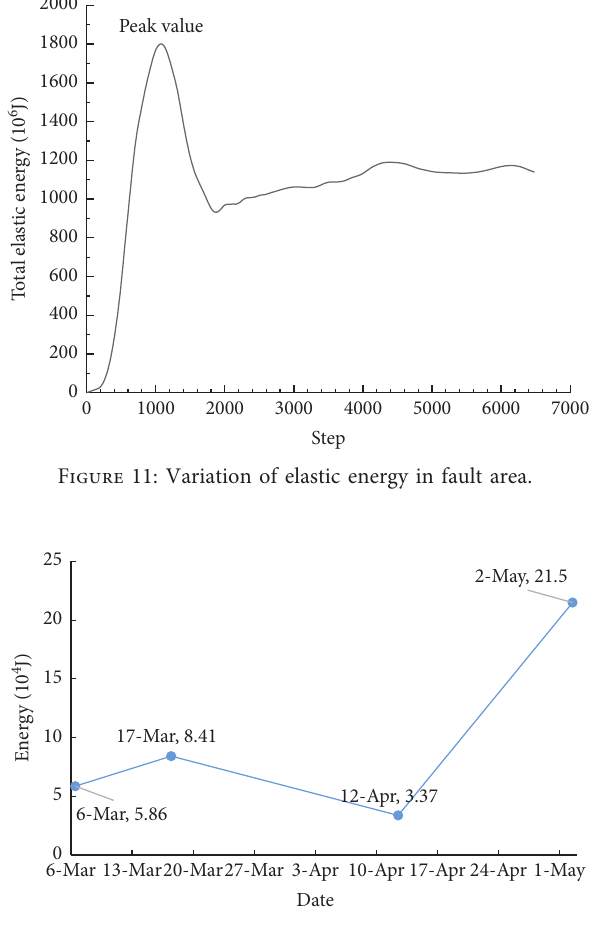
Figure 12: Energy statistical chart of 4 large energy microseismic